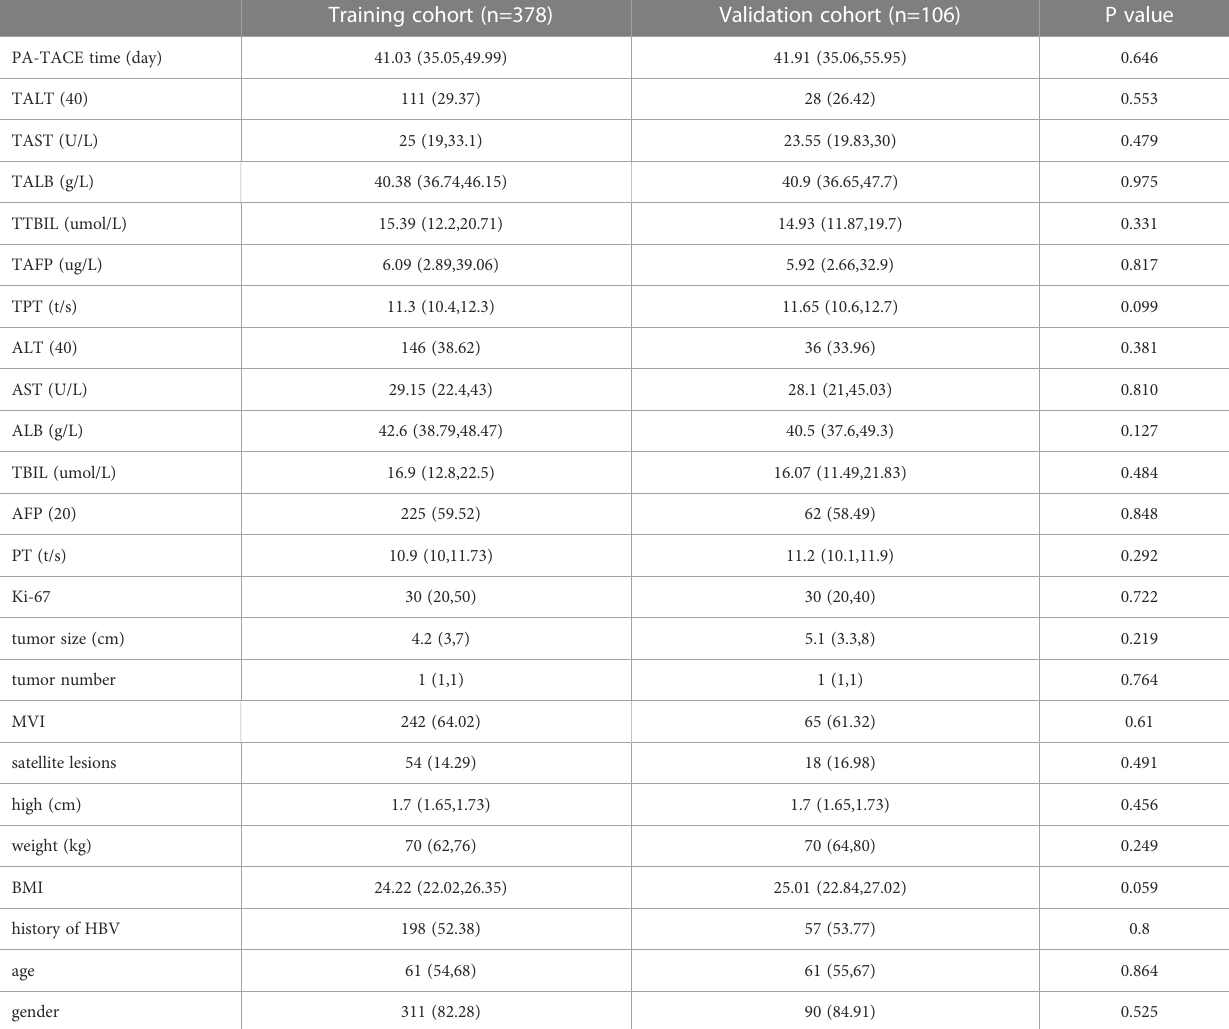
TABLE 1 The demographic and pathological characteristics of the HCC